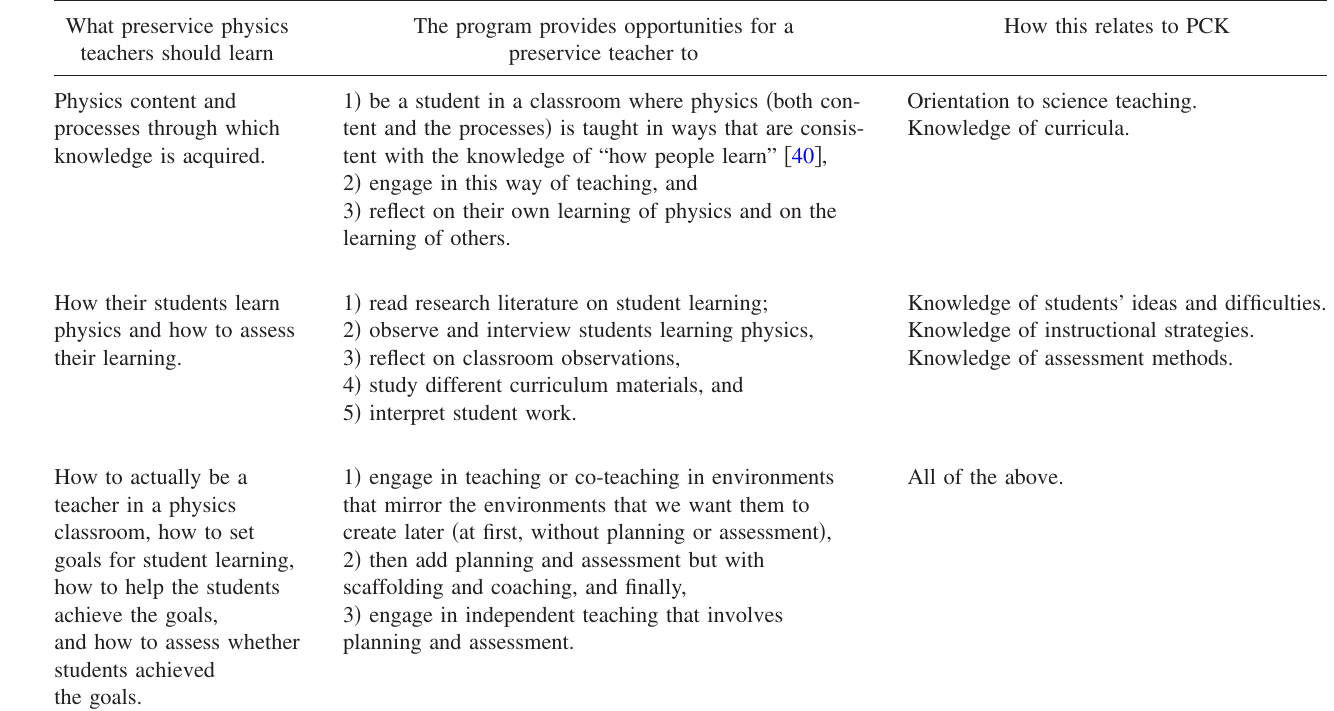
TABLE II. Elements of the teacher preparation